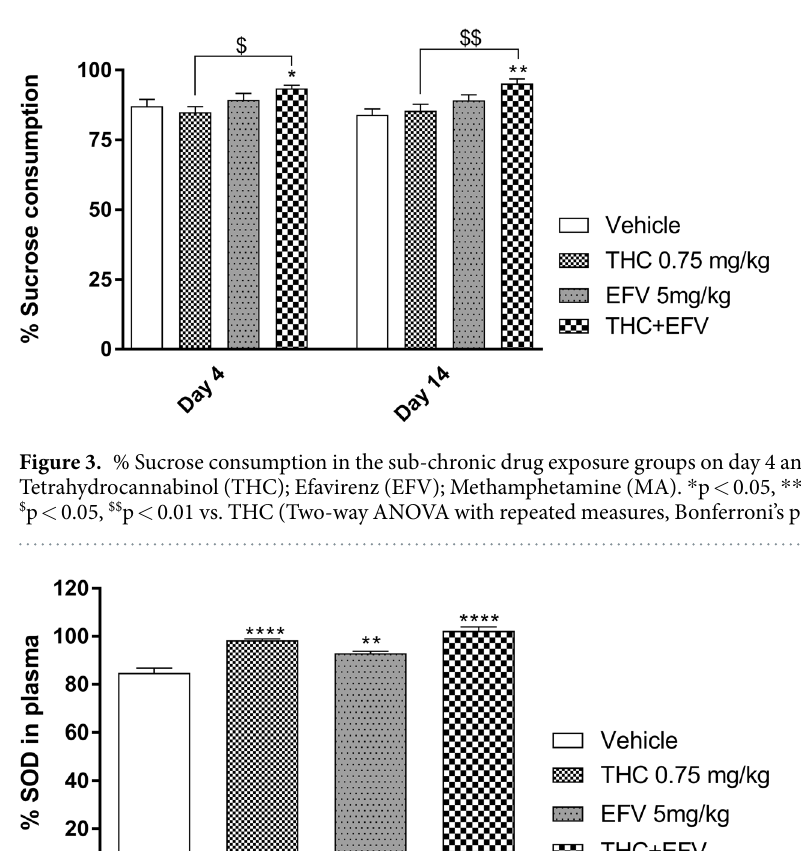
Regional brain monoamines. All regional brain monoamine levels in the different exposure groups are shown in Table 1. One-way ANOVA revealed a significant main effect of drug exposure on: Frontal cortical DA (F (3,44) = 4.39, p = 0.008), DOPAC (F (3, 44) = 8.03, p = 0.0002), 5-HT (F (3, 44) = 12.4, p < 0.0001), 5-HIAA (F (3, 44) = 59.18, p < 0.0001), 5-HIAA/5HT (F (3,44) = 3.24, p < 0.0001 and NA (F (3, 44) = 13, p < 0.0001); Striatal DA (F